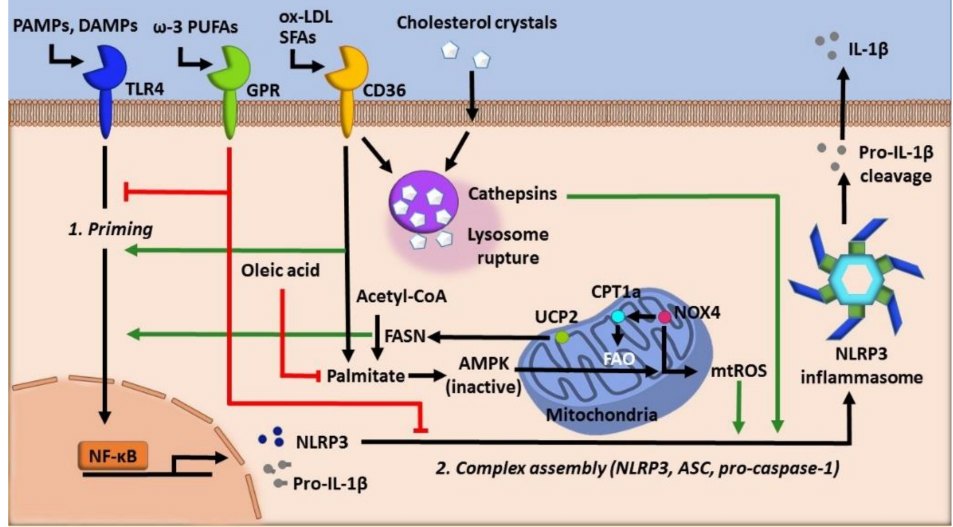
Figure 3. The role of lipids in regulating NLRP3 inflammasome. Lipid species are highly diverse and can either promote or inhibit NLRP3 inflammasome activity. Inflammasome priming, following the first hit, is promoted by both cholesterol crystals and the activity of fatty acid synthase (FASN) during fatty acid synthesis, whereas ω -3 polyunsaturated fatty acids (PUFA) such as docosahexaenoic acid (DHA) inhibit priming and inflammasome complex assembly via cell-surface receptors GPR120 and GPR40. Cholesterol crystals, oxidized LDL (ox-LDL), or saturated fatty acids (SFAs) can be internalized and form crystallized particles within lysosomes. Lipid crystallization can lead to lysosomal membrane rupture, which promotes NLRP3 activation in part by releasing cathepsins and enhancing mtROS production. ThesaturatedfattyacidpalmitatecanalsoactivateNLRP3inflammasomebyinactivatingAMP-activated protein kinase (AMPK) and autophagy, leading to increased mtROS, whereas the monounsaturated oleic acid can inhibit this process. Finally, the fatty acid oxidation pathway promotes inflammasome activation via NADPH oxidase 4 (NOX4)-dependent upregulation of carnitine palmitoyltransferase 1a (CPT1a), likely through mtROS as well. Green lines denote the promotion of NLRP3 activity, whereas red lines denote the inhibition of NLRP3 inflammasome activity. DAMPs: danger-associated molecular patterns, FAO: fatty acid oxidation, GPR: G-protein coupled receptors, PAMPs: pathogen-associated molecular patterns, and UCP-2: mitochondrial uncoupling